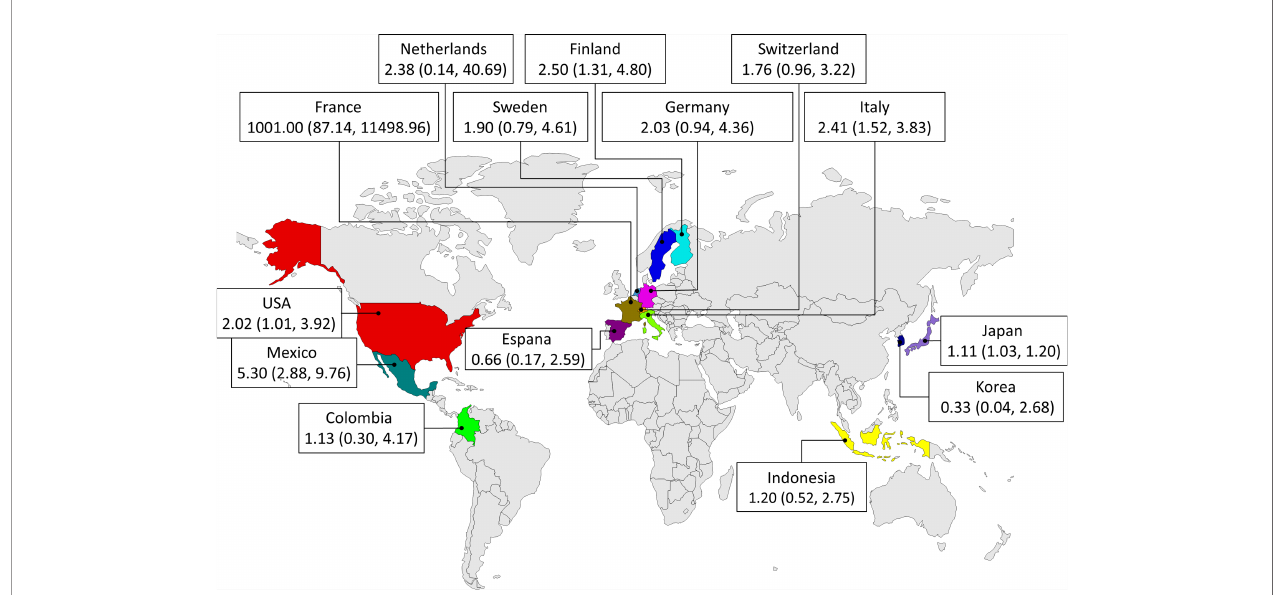
FIGURE 3 | Subgroup analyses of the association between P. gingivalis and rheumatoid arthritis in different